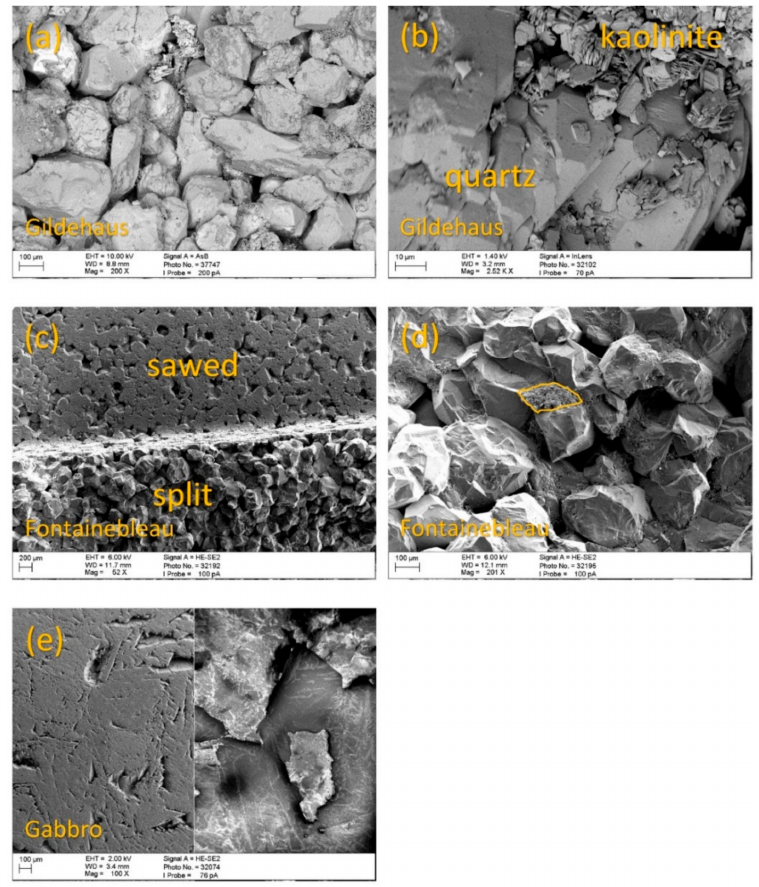
Figure 7. SEM images of the Gildehaus, Fontainebleau, and Gabbro samples. ( a ) and ( b ) show the split surface of the Gildehaus sandstone at two different magnifications. ( a ) shows subhedrally shaped quartz grains and a significant number of cavities. At higher magnification ( b ) a fine-grained kaolinite fraction is visible in between the quartz grains. The kaolinite fraction was also identified in the images of the polished and sawed surface of the Gildehaus sandstone. ( c ) shows that the Fontainebleau sandstone contains subhedral to euhedral quartz grains. At higher magnification ( d ) fine-grained quartz accumulates (highlighted in yellow) become visible in between the larger quartz grains. The images show a significant number of cavities present at the surface. ( e ) shows the polished surface of the Gabbro imaged with the HE-SE2 (left) and the AsB (right). The image shows the surfaces of the Gabbro sample have no significant